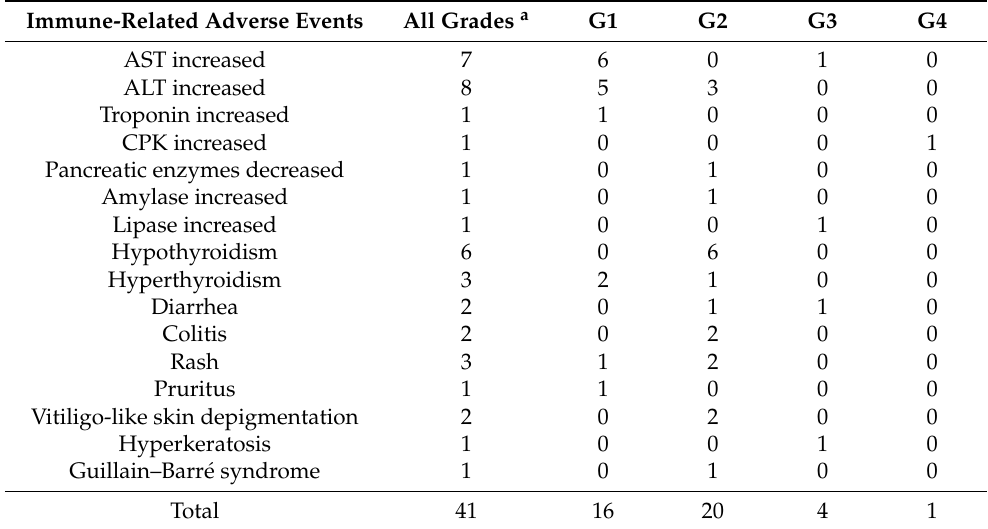
Table 3. Additional irAEs in the Princess Margaret Cancer Centre cohort.